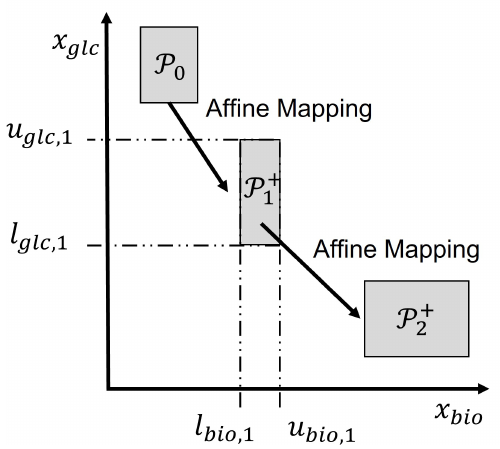
Figure 2. Illustration of set propagation of SME by set